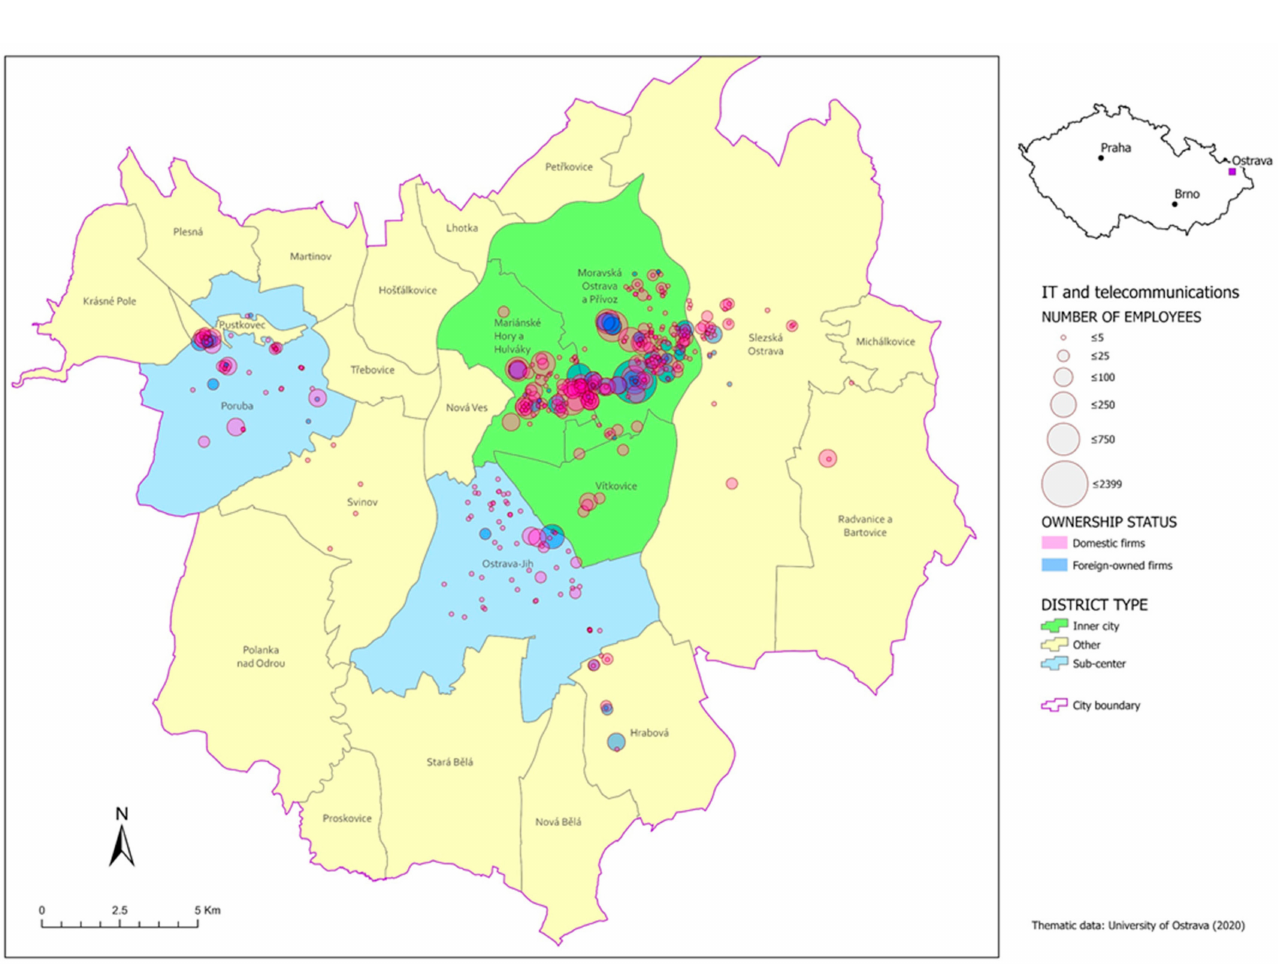
Figure 11. CT firms in Ostrava: size and ownership